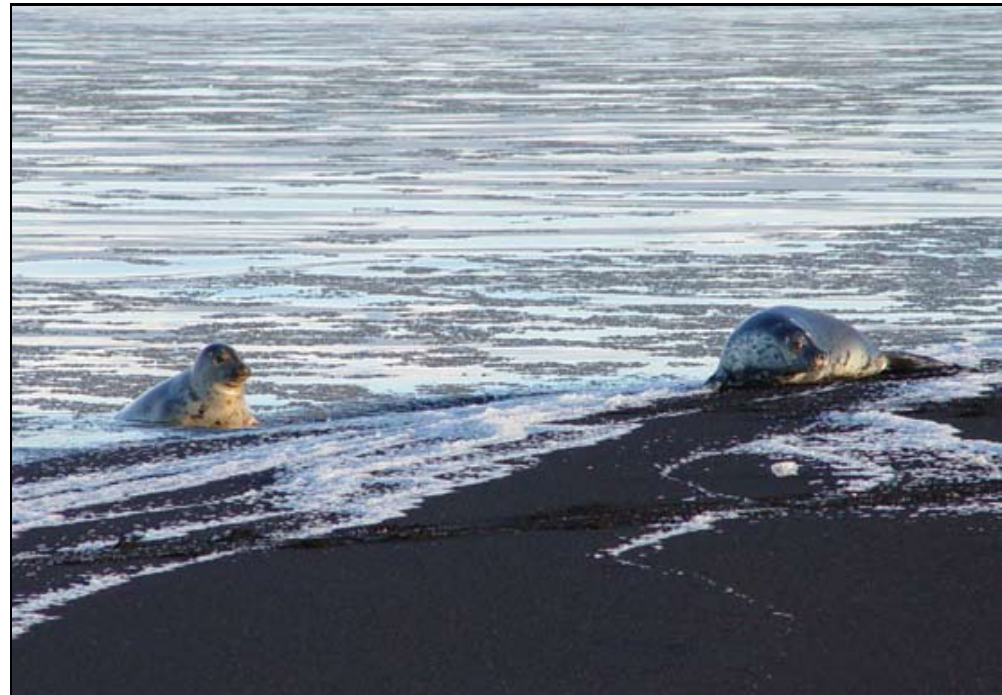
Fig. 1. Grey seals on a beach in Iceland.